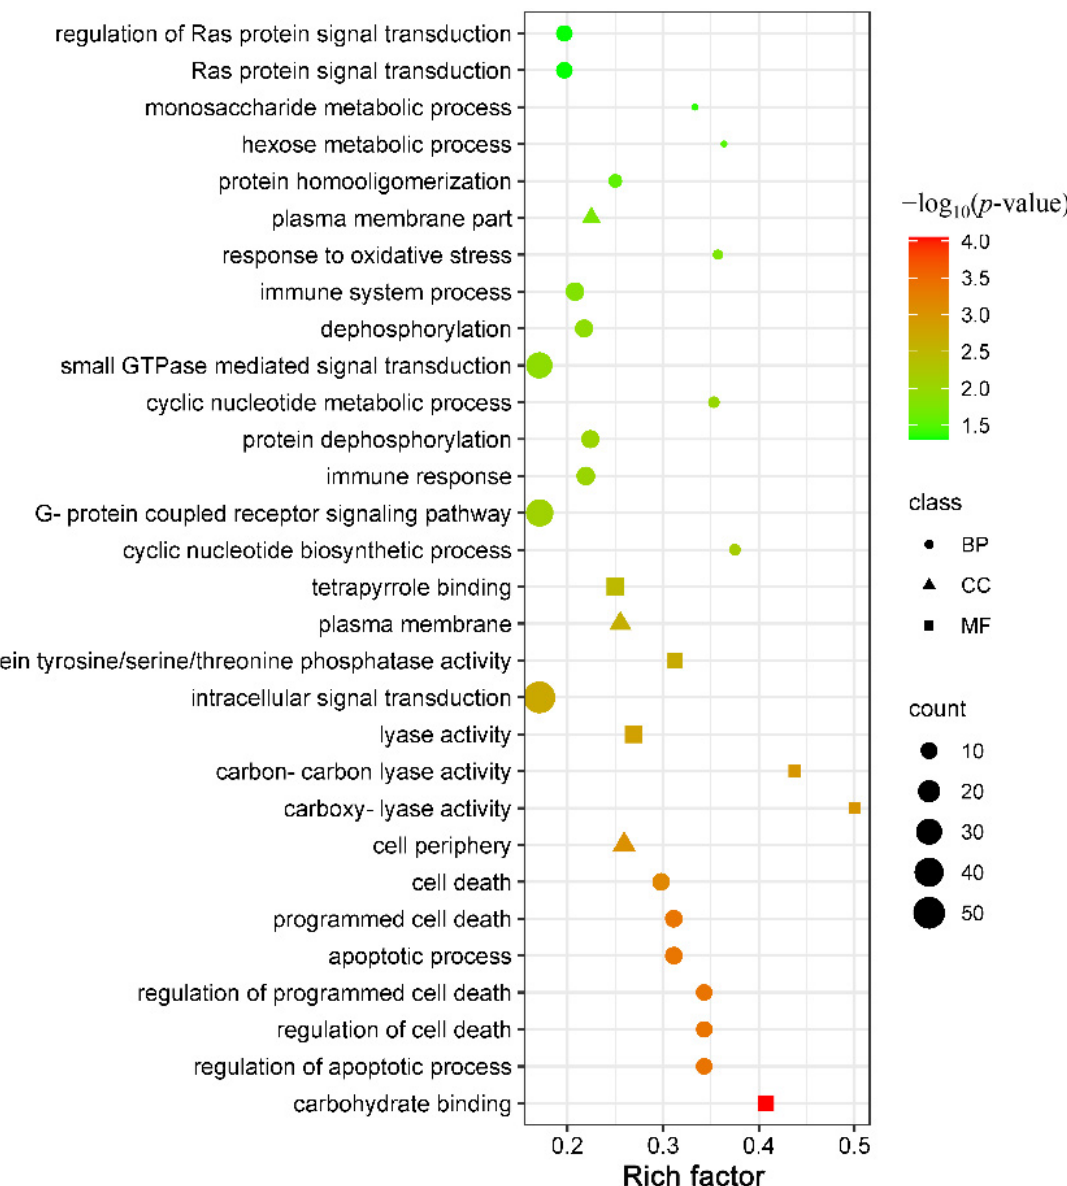
Figure 3. The enrichment score, p -value, count, and class of the top 30 differentially expressed GO terms. The X-axis label represents the rich factor, and the Y-axis label shows the GO terms. The rich factor reflects the proportion of differentially expressed mRNAs (DEmRNAs) in a given GO term. The greater the rich factor, the greater the degree of term enrichment. The color of the dots represents the enrichment score [ − log 10 ( p -value)], where red indicates high enrichment and green indicates low enrichment. Dot size represents the number of DEmRNAs in the corresponding term (bigger dots indicate larger DEmRNA numbers).